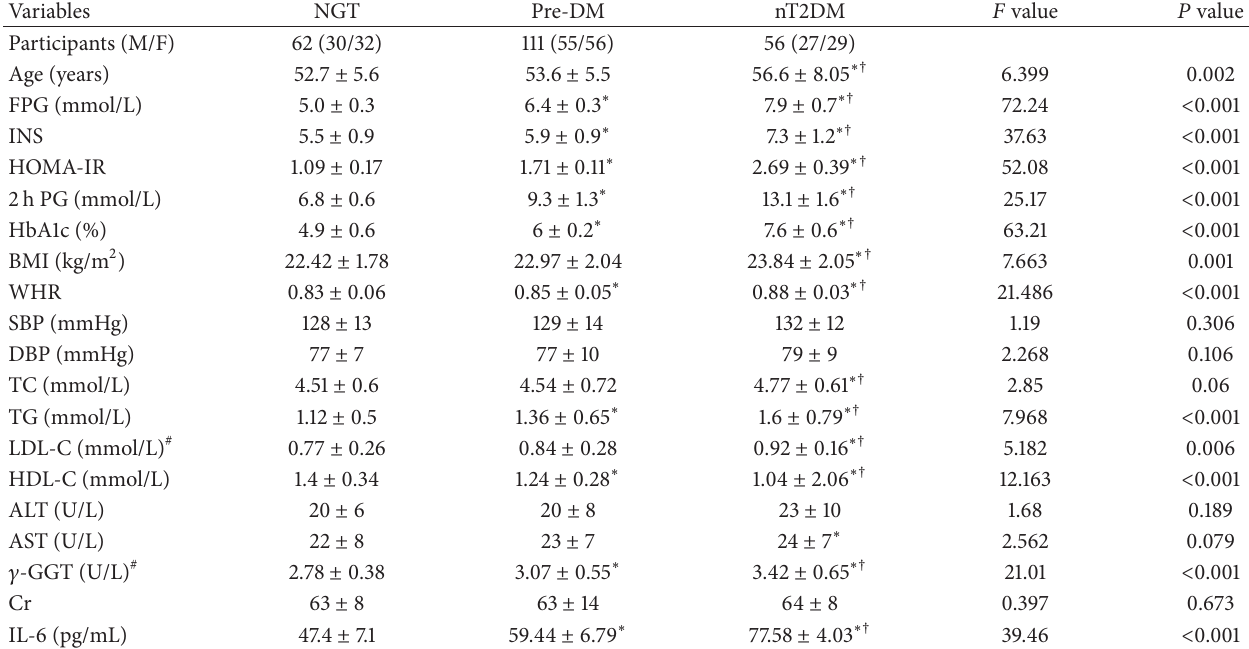
Table 1: Clinical and biochemical characteristics of the study